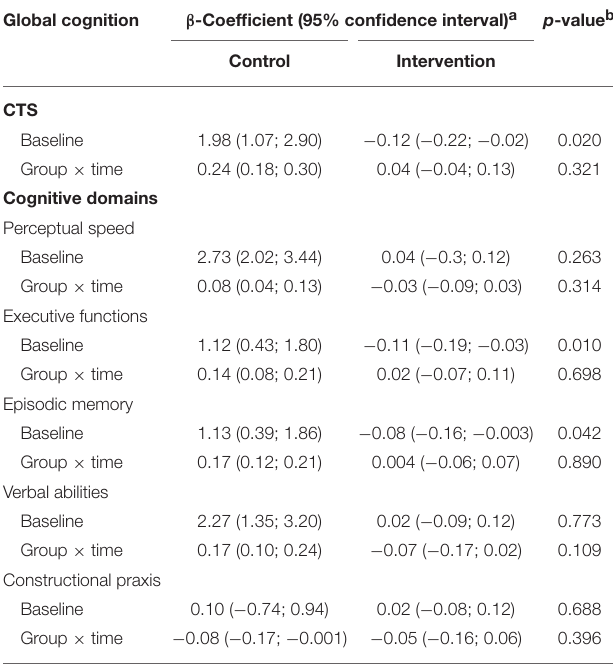
TABLE 3 | Estimated change in global and domain-specific cognitive functioning 1-year after randomization in control ( n = 641) and intervention ( n = 638) groups. Global